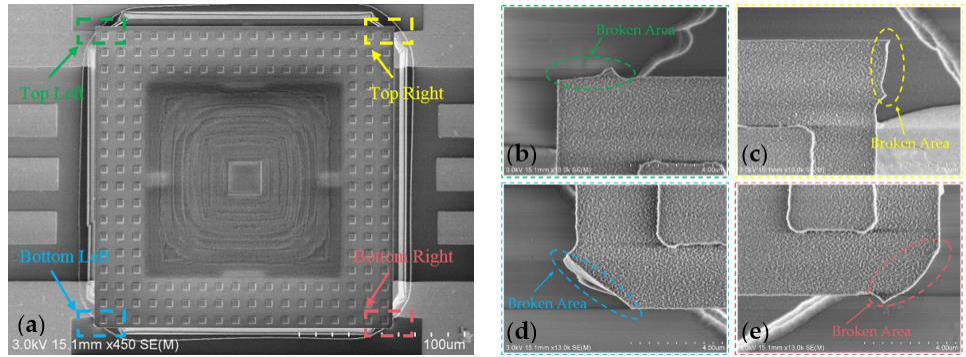
Figure 12. SEM view of the broken area of the temporary support structures of the tactile sensor. ( a ) SEM view of transferred device; ( b – e ) enlarged SEM views of the broken area shown in ( a ).